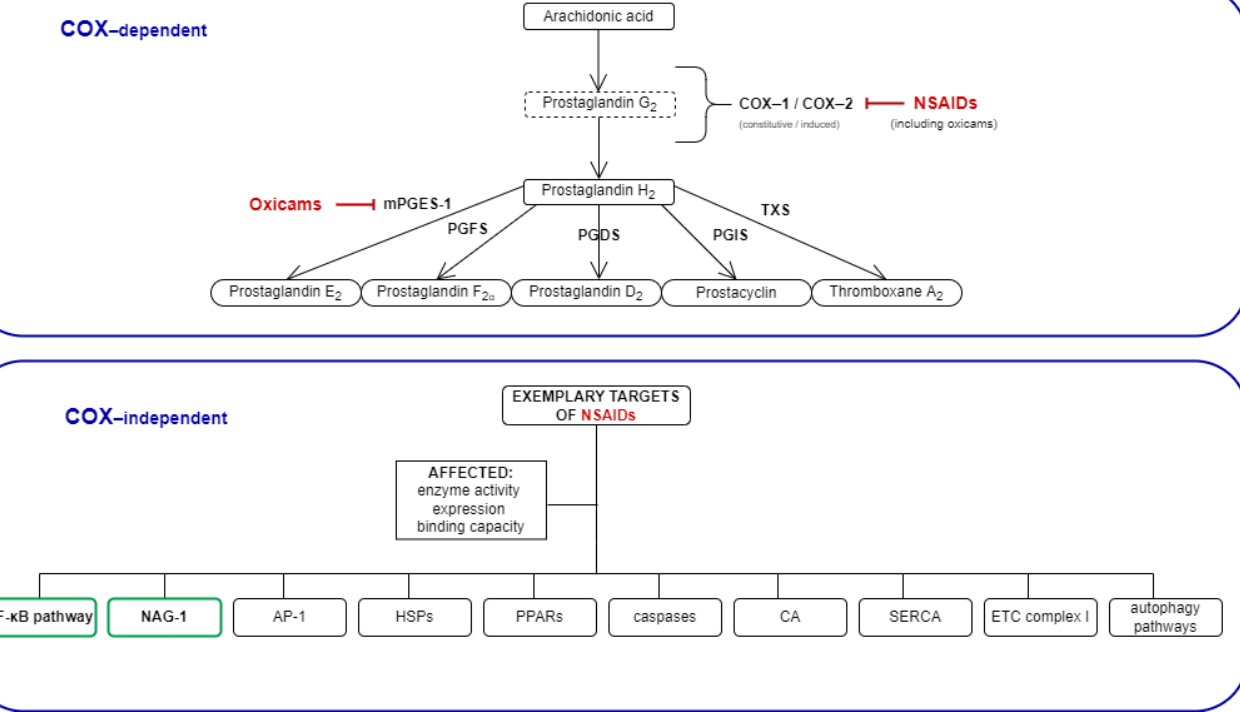
Figure 1. Mechanisms of NSAIDs’ action: COX-dependent and exemplary COX-independent targets relevant for cancer development. The COX-independent targets evaluated in the present study are bolded, and are indicated by a green frame. NSAIDs, non-steroidal anti-inflammatory drugs; COX, cyclooxygenase; mPGES, microsomal prostaglandin E2 synthase; PGFS, prostaglandin F synthase; PGDS, prostaglandin D synthase; PGIS, prostacyclin synthase; TXS, thromboxane synthase; NAG-1, NSAIDs-activated gene; AP-1, activator protein 1; HSPs, heat shock proteins; PPARs, peroxisome proliferator-activated receptor; CA, carbonic anhydrase; SERCA, sarco (endo)-plasmic calcium ATPase; ETC, electron transport chain.